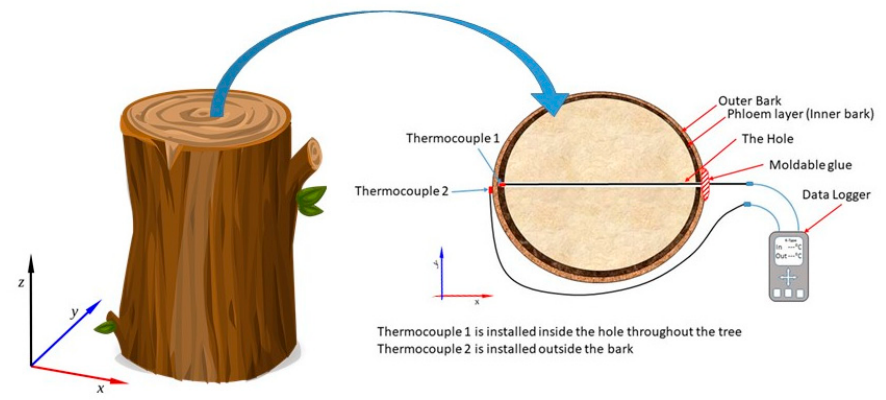
Figure 3. Cross-section of the sample with thermocouples installed in the phloem and on the surface.